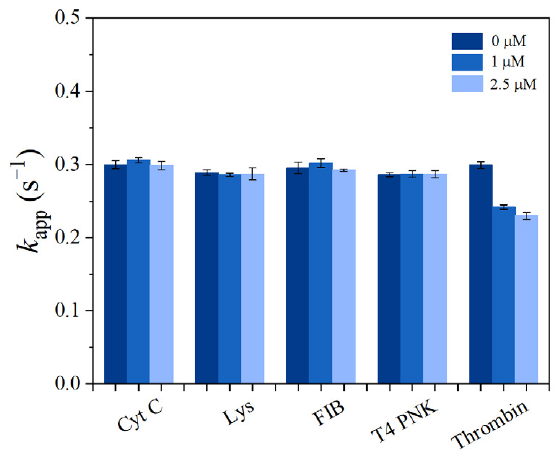
Figure 8. The apparent fluorescence attenuation rate constant k app of SITS-Thrombin27 5 ′ in the presence of Cyt C (1 and 2.5 µ M), Lys (1 and 2.5 µ M), FIB (1 and 2.5 µ M), T 4 PNK (35 U · mL − 1 and